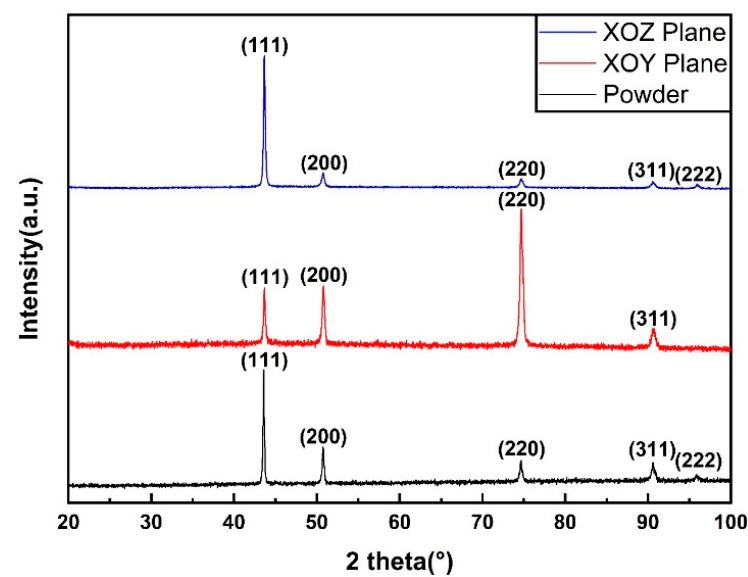
Figure 2. X-ray diffraction patterns of CoCrFeMnNi powder and SLM processed samples. Figure 2. X-ray di ff raction patterns of CoCrFeMnNi powder and SLM processed